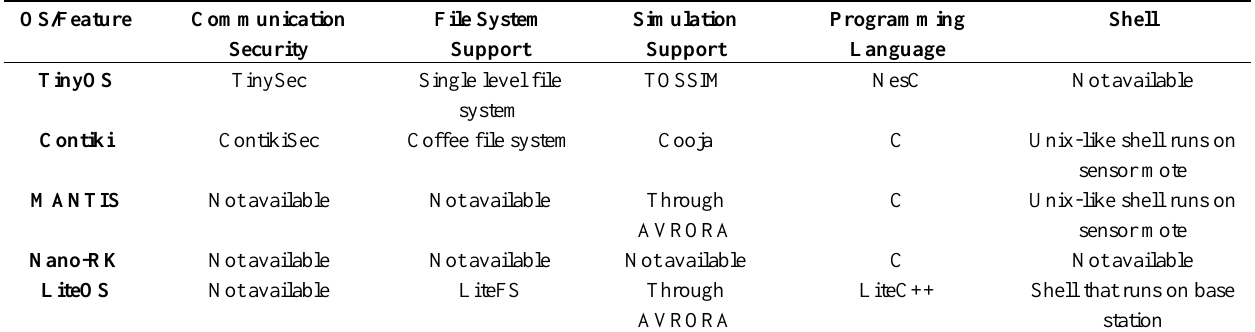
Table 2. Miscellaneous Features